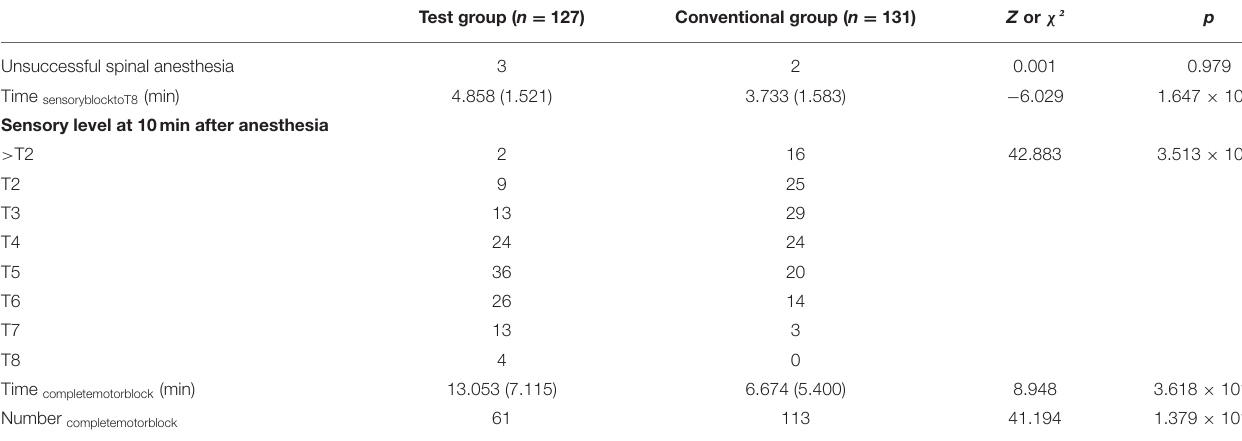
TABLE 4 | Characteristics of spinal